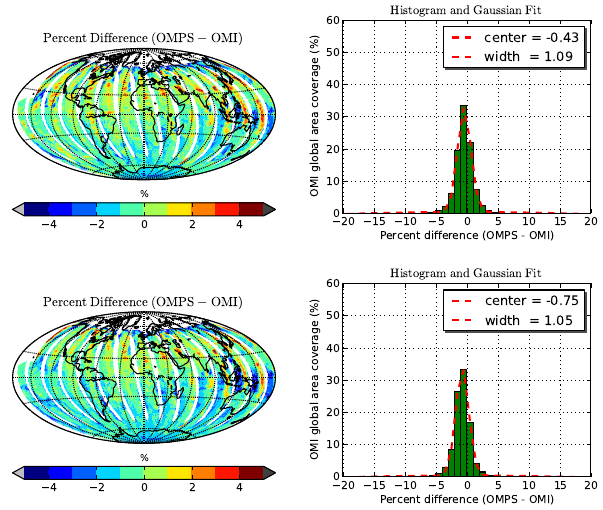
Figure 8. Total ozone differences between OMPS and OMI on 7 January 2013 with the use of the cloud OCP climatology (top) and the retrieved cloud OCP (bottom). The left panels show spatial distributions of the total ozone differences; the right panels show histograms of total ozone differences and their approximation with a Gaussian function.